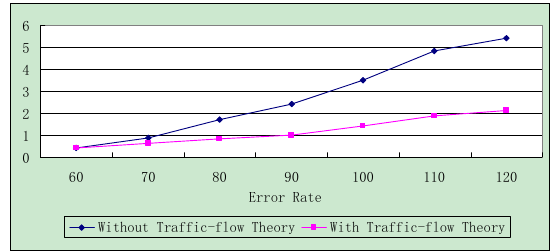
Fig.6. Error rate at different